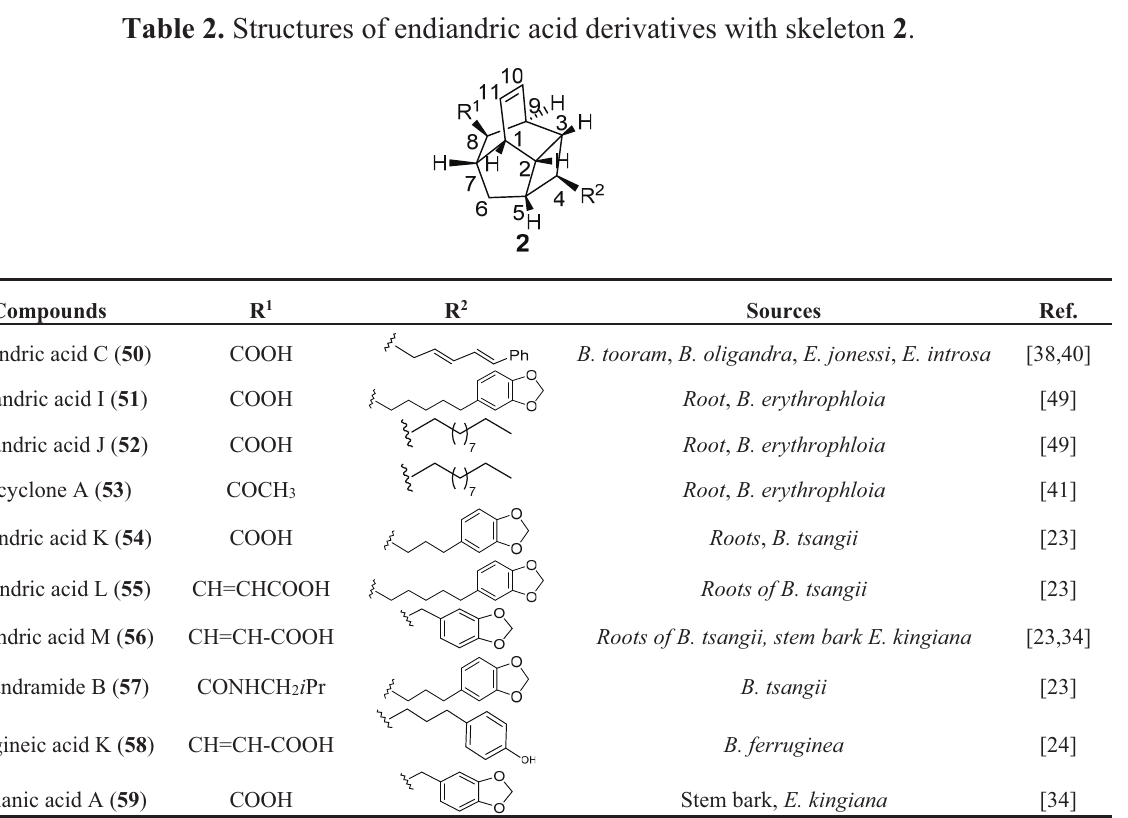
Table 2. Structures of endiandric acid derivatives with skeleton 2